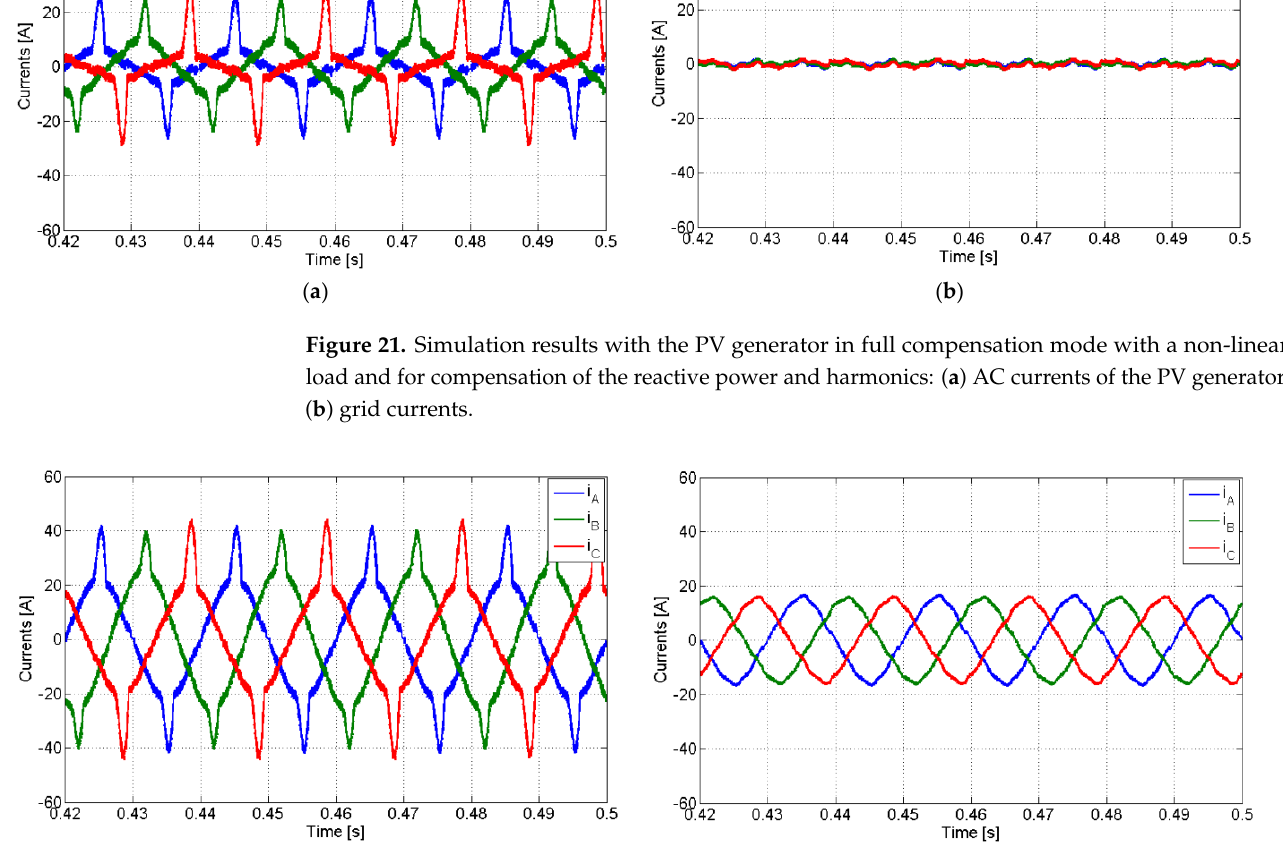
Figure 22. Simulation results with the PV generator in overcompensation mode with a non-linear load and for compensation of the reactive power and harmonics: ( a ) AC currents of the PV generator; ( b ) grid currents.